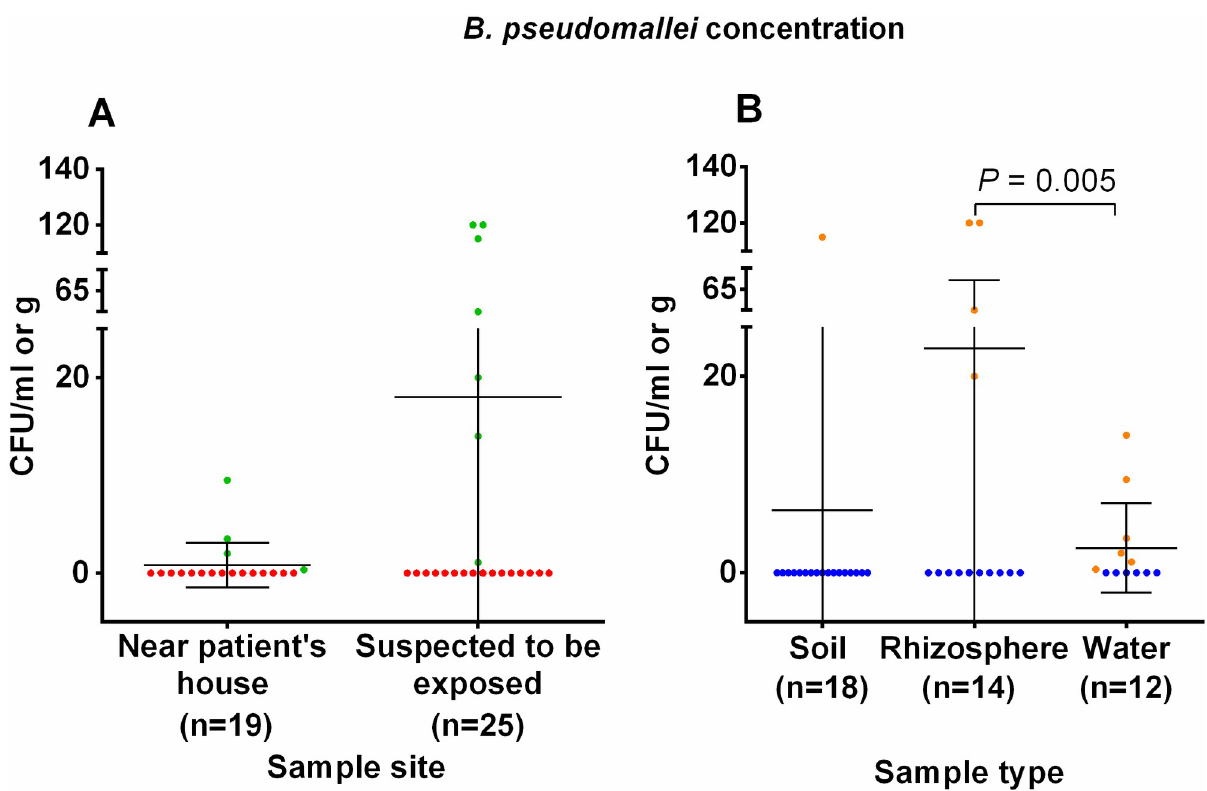
Fig 4. Concentrations of B . pseudomallei from two sampling sites and three different sample types. (A) Concentration of B . pseudomallei in all environmental samples from two sampling sites: near the patient’s house and to which the patient was suspected to be exposed. (B) Concentration of B . pseudomallei in the soil, rhizosphere, and water